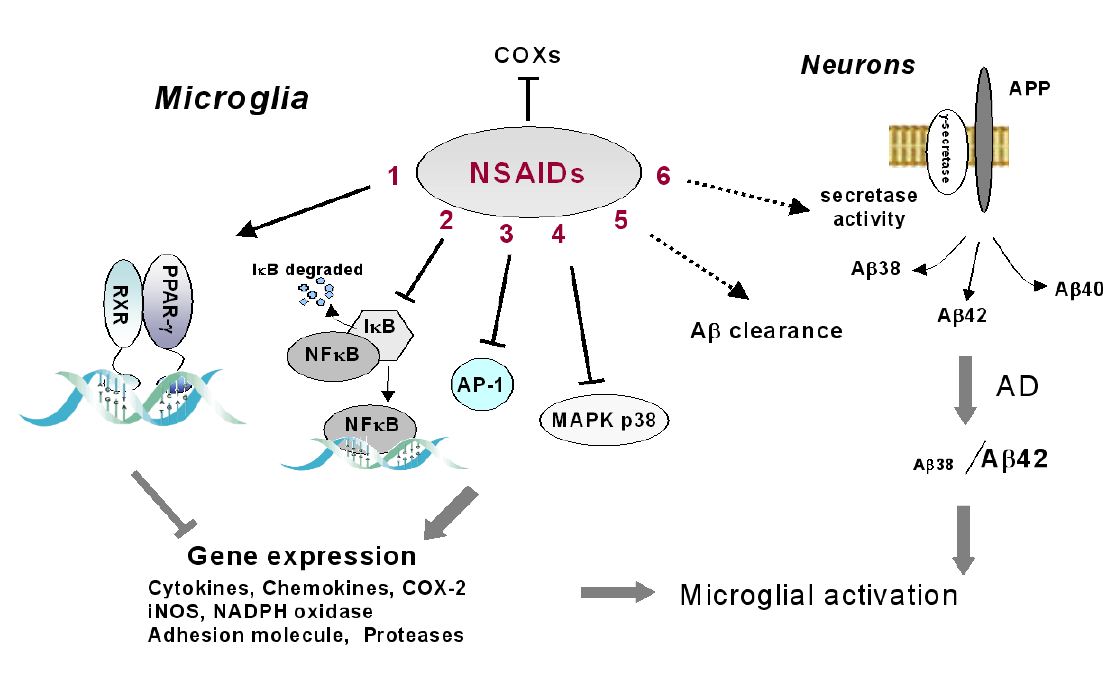
Figure 1. Schematic representation of direct and indirect effects of NSAIDs on microglial functions. Besides inhibiting COX activity, some NSAIDs can repress the expression of genes typically associated with microglial activation by interfering with NF-kB, AP-1 and MAPK p38 signaling, and activating PPAR- γ . NSAIDs can also indirectly limit microglial activation, by interfering with secretase activity in neurons and reducing A β load. The effects of NSAIDs on microglial A β clearance are still controversial (dotted